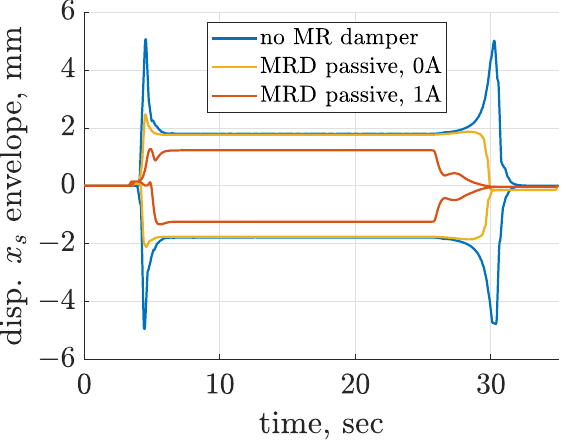
Figure 18. Comparison of time diagrams of envelopes evaluated for the horizontal displacement x s in the case of the screen model without an MR damper model included and with an MR damper controlled by a constant current equal to 0 or 1